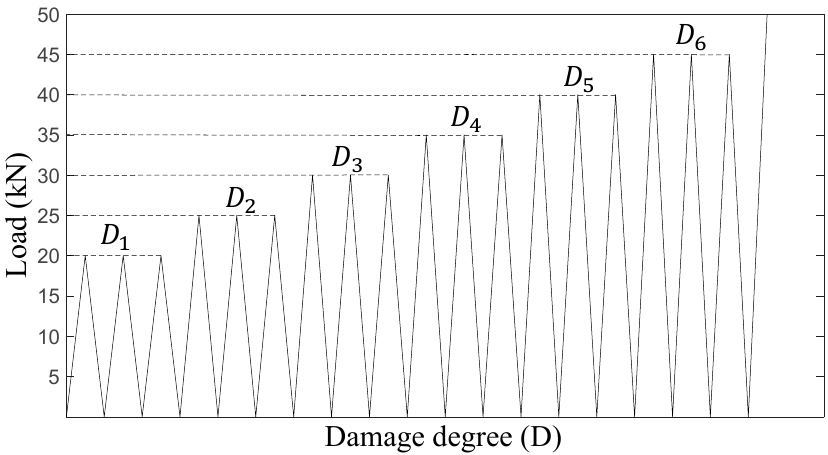
Figure 3. Loading-unloading regime of the repeated loading.